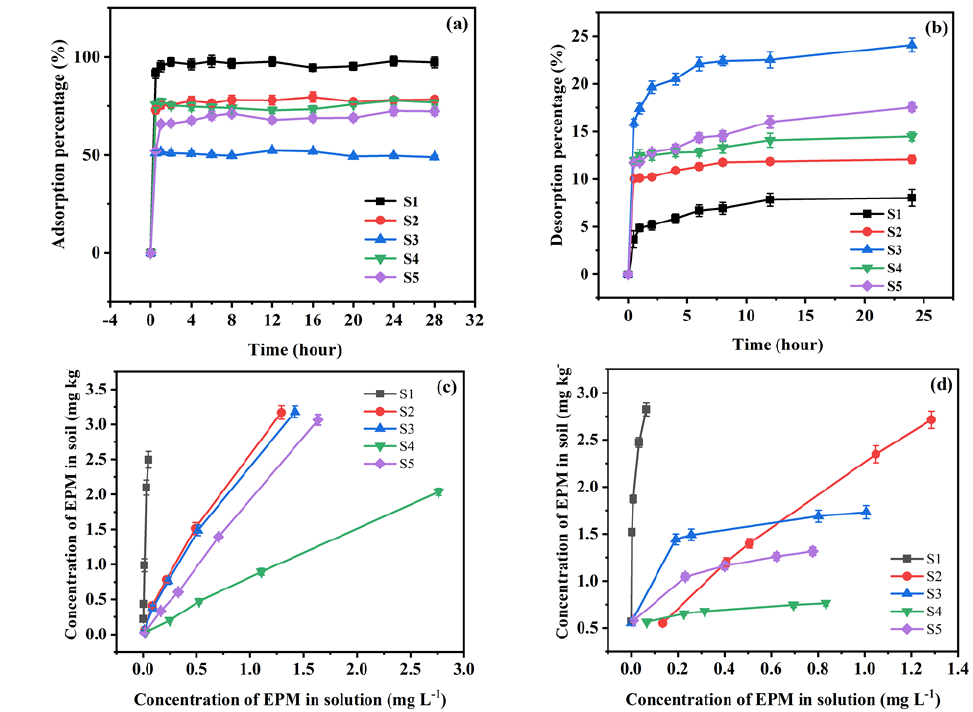
Figure 1. Adsorption (a) and desorption (b) kinetic curves and adsorption (c) and desorption (d) isothermal curves of EPM in five different agricultural soils ( S 1 to S 5 , as defined in Table 1). Values are the means ± standard error ( n = 3). Table 1. Comparison between the results of the linear and Freundlich models for the adsorption–desorption (ads and des, respectively) of EPM in five agricultural